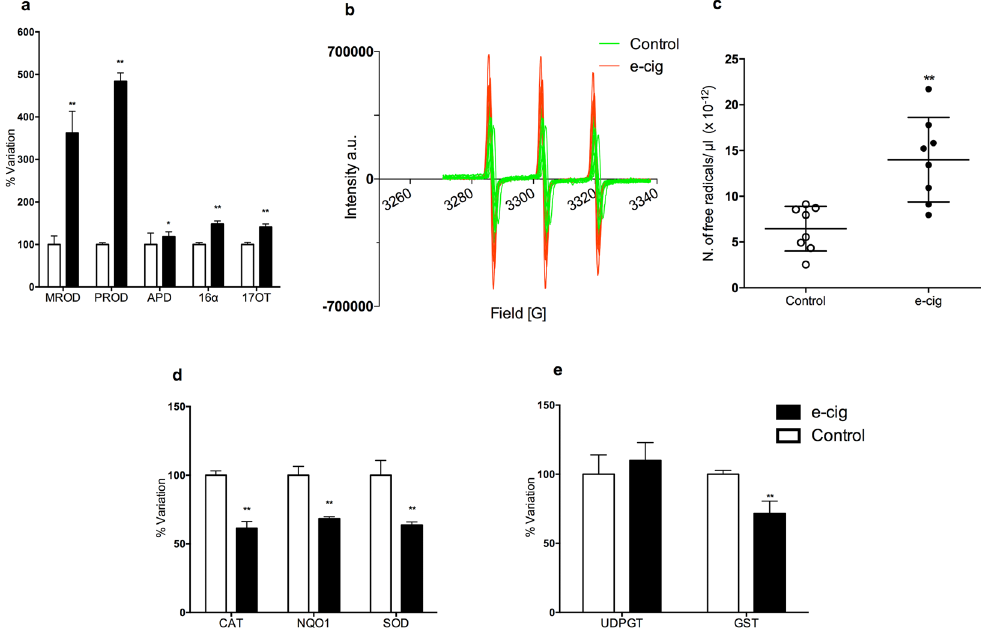
Figure 1. Metabolic/antioxidant enzymes and free radical yield in e-cig-exposed rat lung. ( a ) Cytochrome P450 (CYPs) is a superfamily of major isoenzymes involved in drug metabolism. CYP activities lead to the bioactivation of ubiquitous pre-mutagens and pre-carcinogens as well as ROS generation linked to their catalytic cycle. Data were obtained through enzymatic assays performed on microsomal lung fractions using several specific probes: MROD (CYP1A2-like) increased up to 262%, PROD (2B1/2) 384%, APD (3A, 1A, 2A, 2D) 19% P < 0.05, 16- α TOH (2B1/2C11) 48% ( P < 0.01), 17-TOH (3A1) 41% ( P < 0.01). ( b ) EPR spectra of nitroxide radicals observed in rat lung tissues in control samples (green spectra), and in e-cig vapour- treated samples (red spectra). ( c ) EPR intensity of the first spectral line of the observed nitroxide radicals (arbitrary units). ( d ) Antioxidant enzymes: CAT, NQO1 and SOD were reduced more than 32% ( P < 0.01). ( e ) Transferases shown here are involved in the detoxifying step of xenobiotic metabolism making drugs or toxins more water-soluble. They also contribute to preserving DNA from adduct formation converting carcinogens into inactive or less toxic compounds: UDP-GT unchanged, GST 28% loss ( P < 0.01). Each bar represents the means ± S.D. of ten measurements performed on ten rats, * P < 0.05, ** P < 0.01, two-tailed t